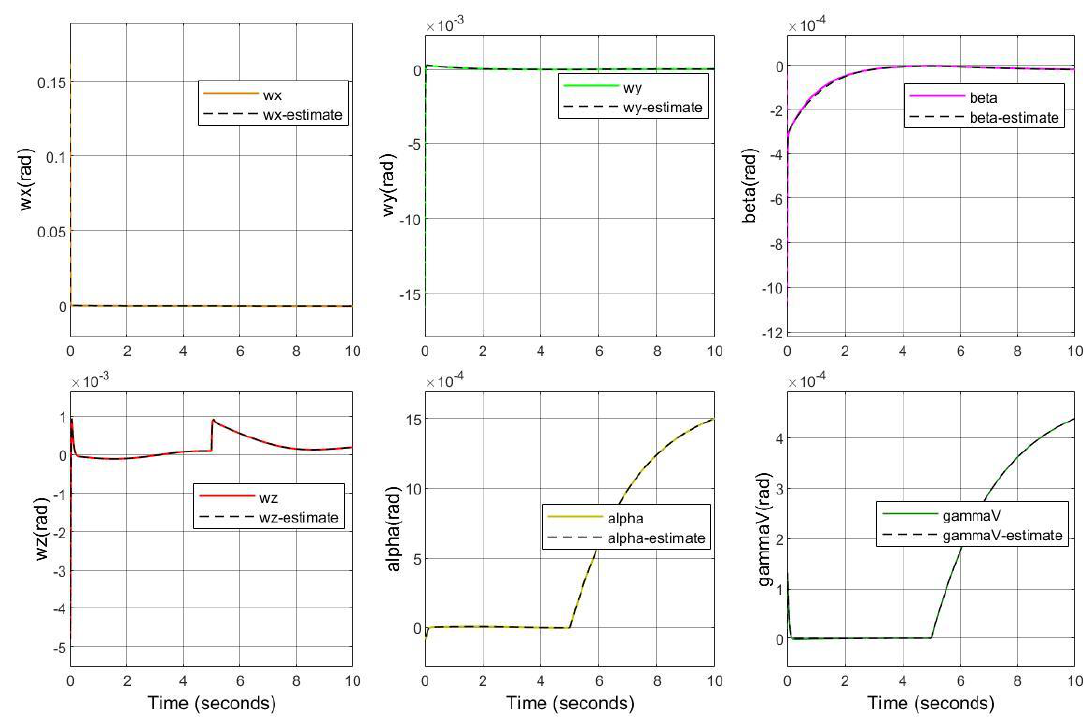
Figure 5. Detection simulation results of actuator stuck fault from input 2.